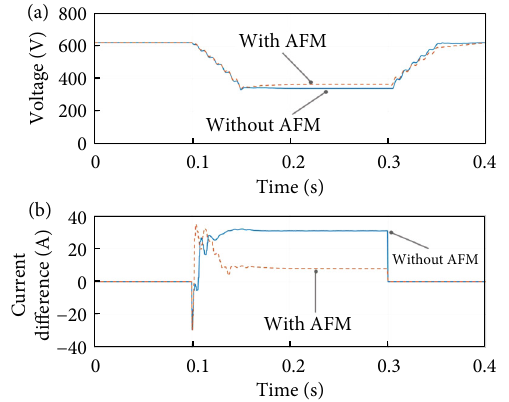
Fig. 16 Resilience curves for ( a ) voltages at microgrids’ point of connection and ( b ) fault current contributions.